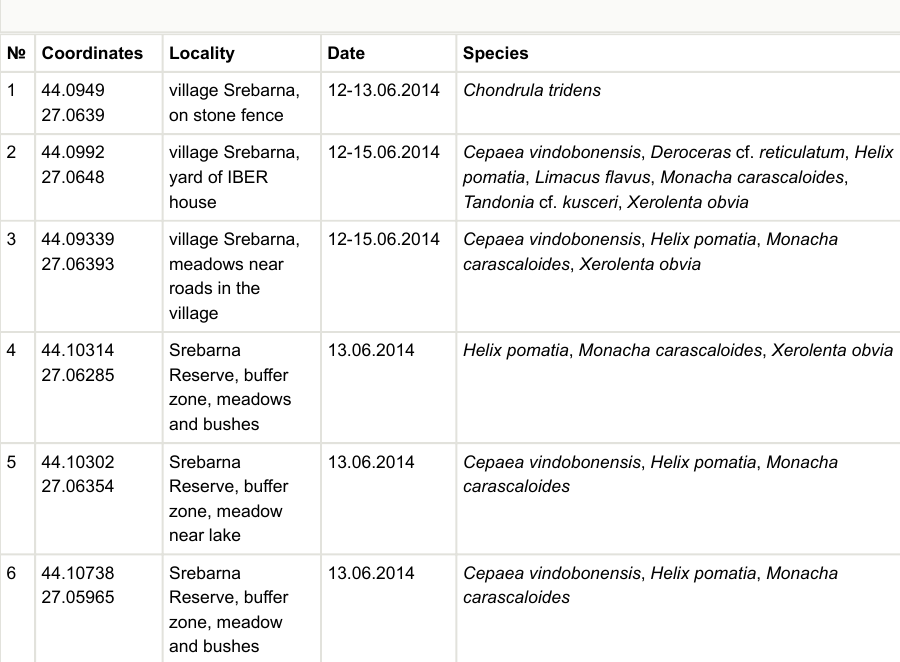
Studied localities in Srebarna Nature